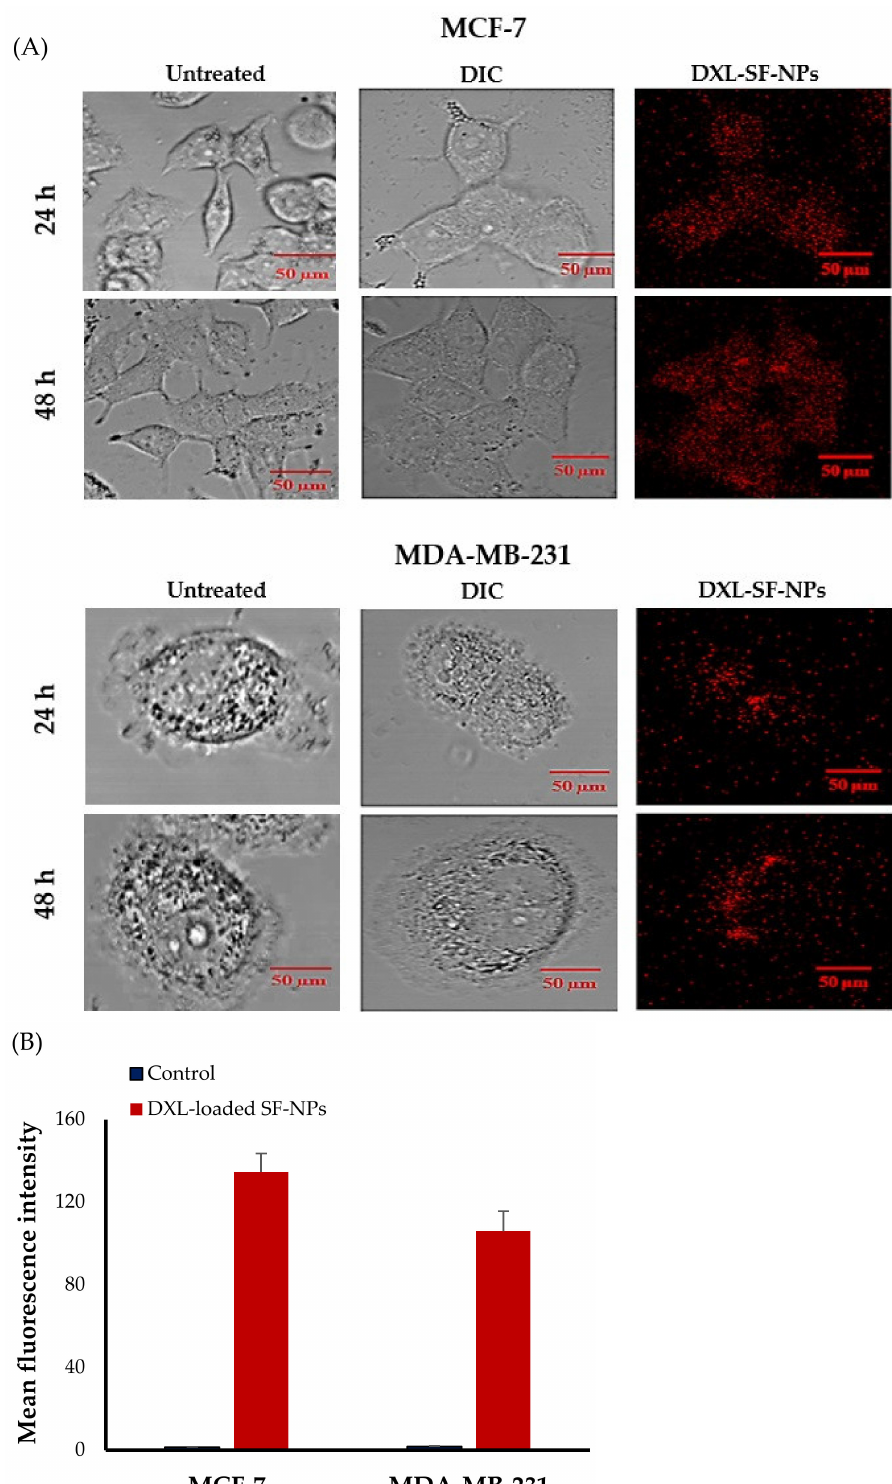
Figure 5. ( A ) Qualitative cellular uptake study of DXL-loaded SF-NPs by MCF-7 and MDA-MB-231 breast cancer cells by confocal microscopy analysis. DIC refers to differential interference contrast image. ( B ) Quantitative assessment of cellular uptake of DXL-loaded SF-NPs by MCF-7 and MDA- MB-231 breast cancer cells by flow cytometric